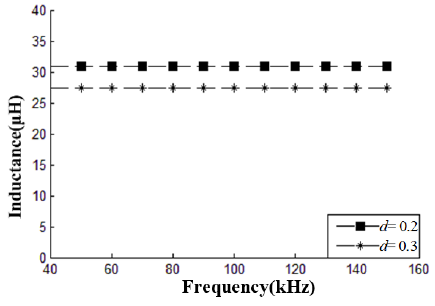
Figure 7. Effect of frequency on inductance parameters of the receiving coil.